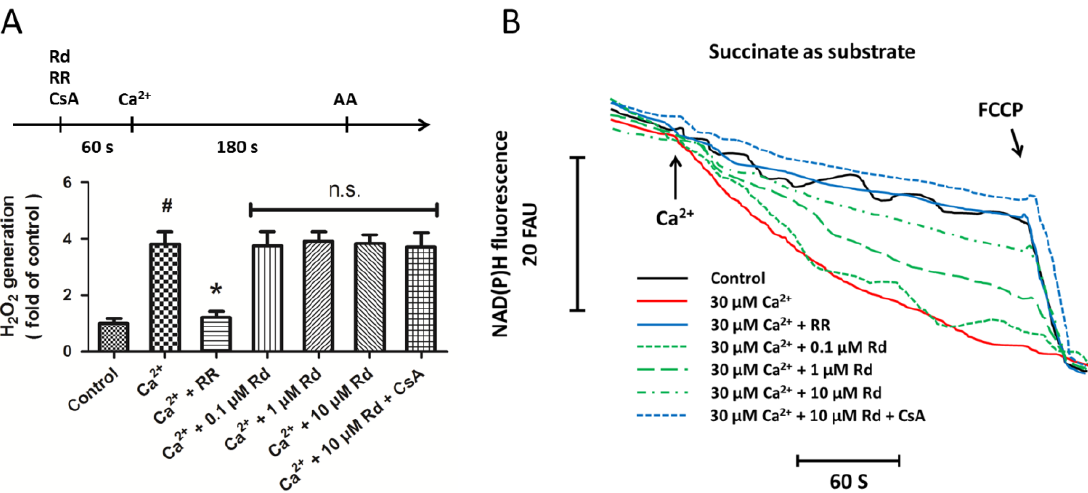
Figure 3. Effects of Rd on mitochondrial H O generation and NAD(P)H content after 2 2 Ca 2+ treatment in isolated spinal cord mitochondria. ( A ) Isolated spinal cord mitochondria (0.5 mg protein/mL supported by succinate) were treated with Rd at different concentrations (0.1, 1, or 10 μM) in the presence or absence of 1 μM RR and 1 μM CsA. The mitochondrial H O generation was measured, and 0.1 μg/mL Antimycin A (AA) was 2 2 added to induce maximal H O generation at the end of the measurements; ( B ) Isolated 2 2 spinal cord mitochondria (0.5 mg protein/mL supported by succinate) were treated with Rd at different concentrations (0.1, 1, or 10 μM) in the presence or absence of 1 μM RR and 1 μM CsA. The mitochondrial NADH and NADPH content was measured, and 1 μM FCCP was added to induce maximal NAD(P)H oxidation at the end of the measurements. The data were represented as means ± SD from five experiments. Traces are representative of three independent experiments performed in duplicate and were expressed as fluorescence